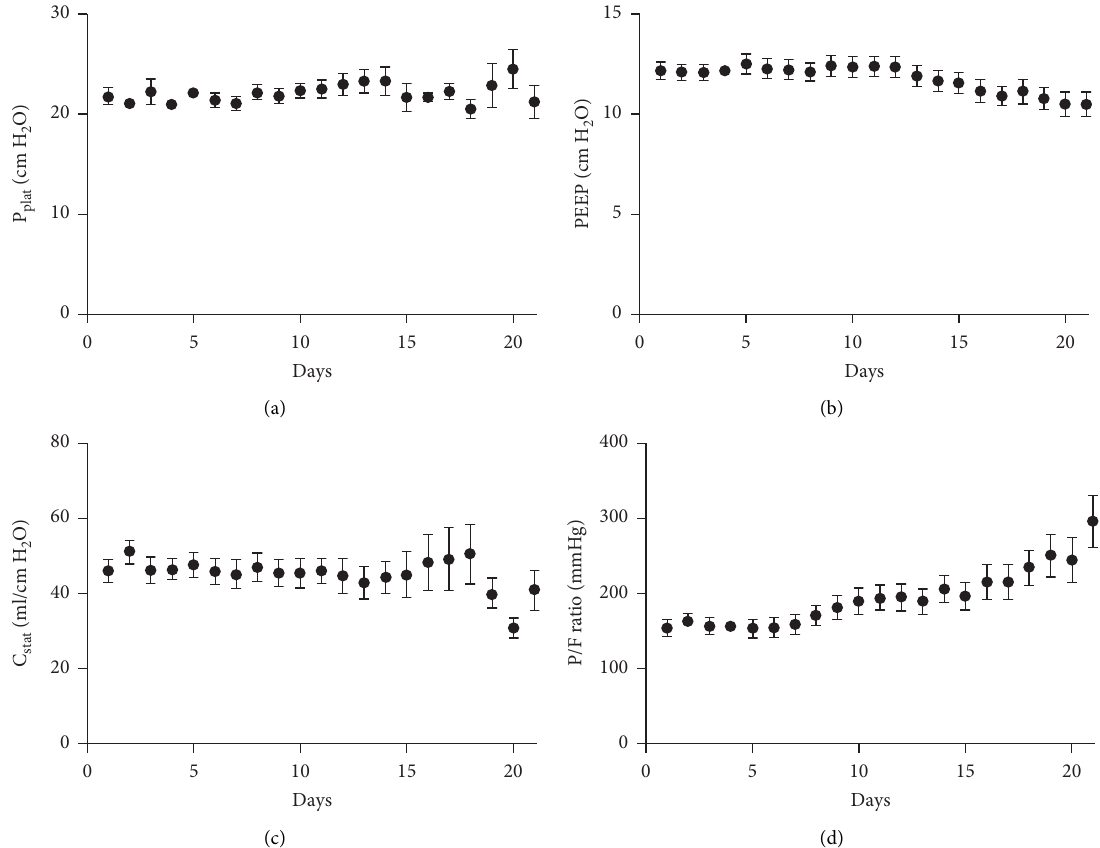
Figure 4: Ventilatory characteristics of COVID-19 patients. P compliance; P/F ratio: PaO 2 /FiO 2